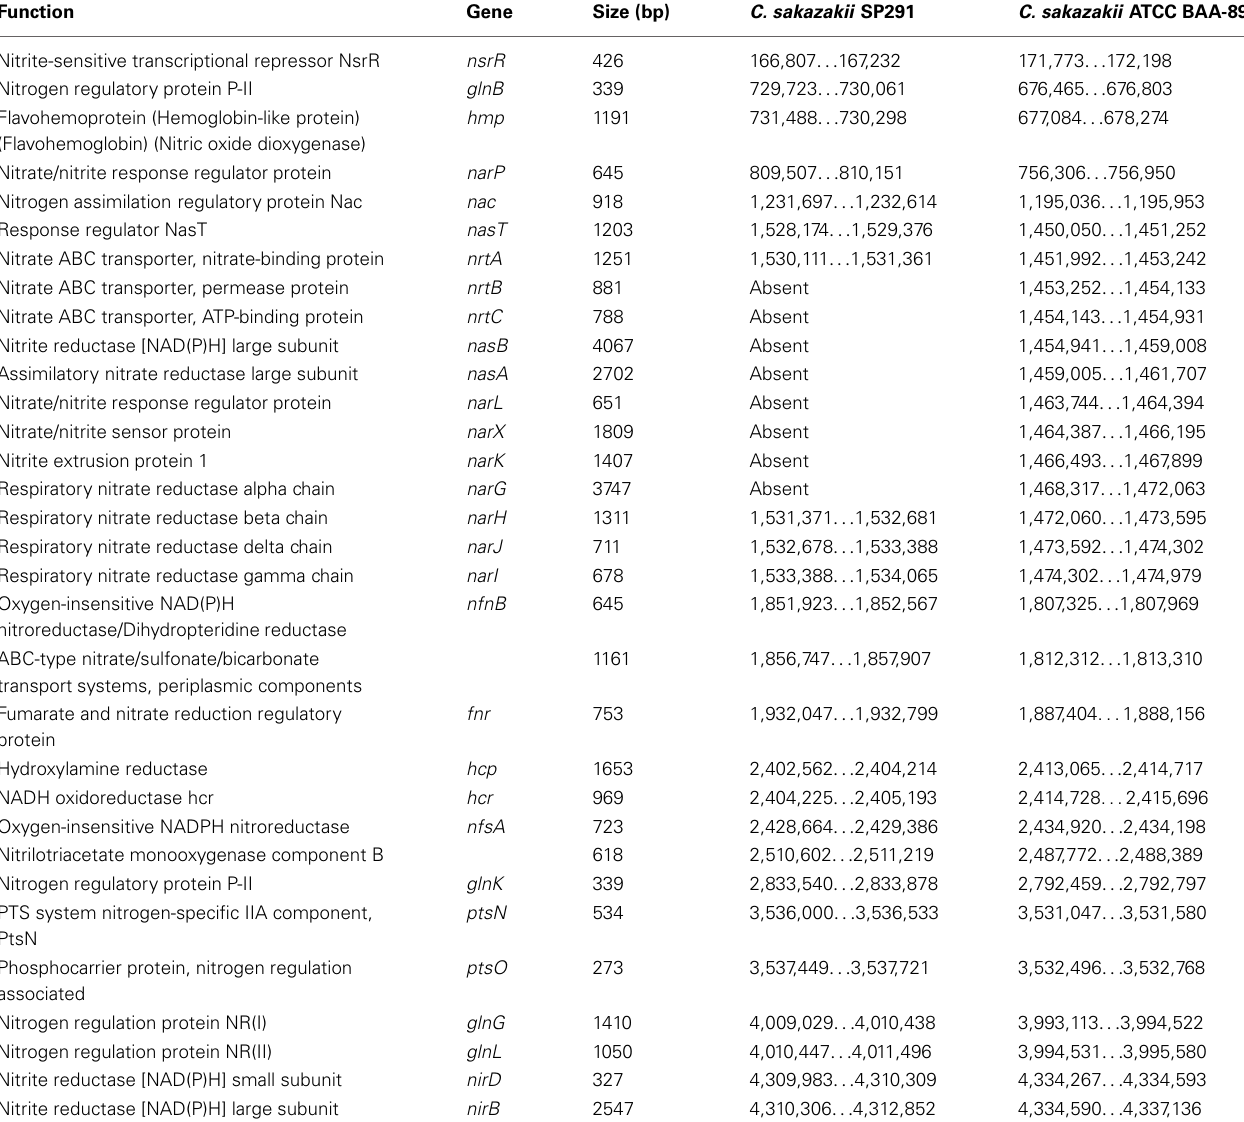
Table 3 | Genes associated with nitrogen metabolism, comparing C. sakazakii SP291 and C. sakazakii ATCC BAA 894.